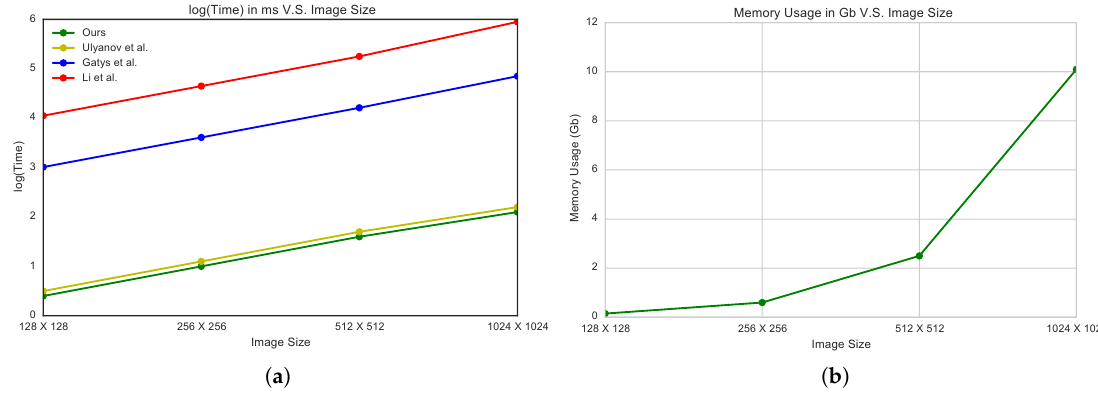
Figure 11. ( a ) Speed comparison (in log space) between our method and Gatys et al. [2], Li et al. [38] and Ulyanov et al. [39]. The feed-forward methods (ours and Ulyanov et al. [39]) are significantly faster than Gatys et al. [2] (500-times speed up) and Li et al. [38] (5000-times speed up). ( b ) Memory usage vs. image size, the required memory is linearly related to the size of input image.